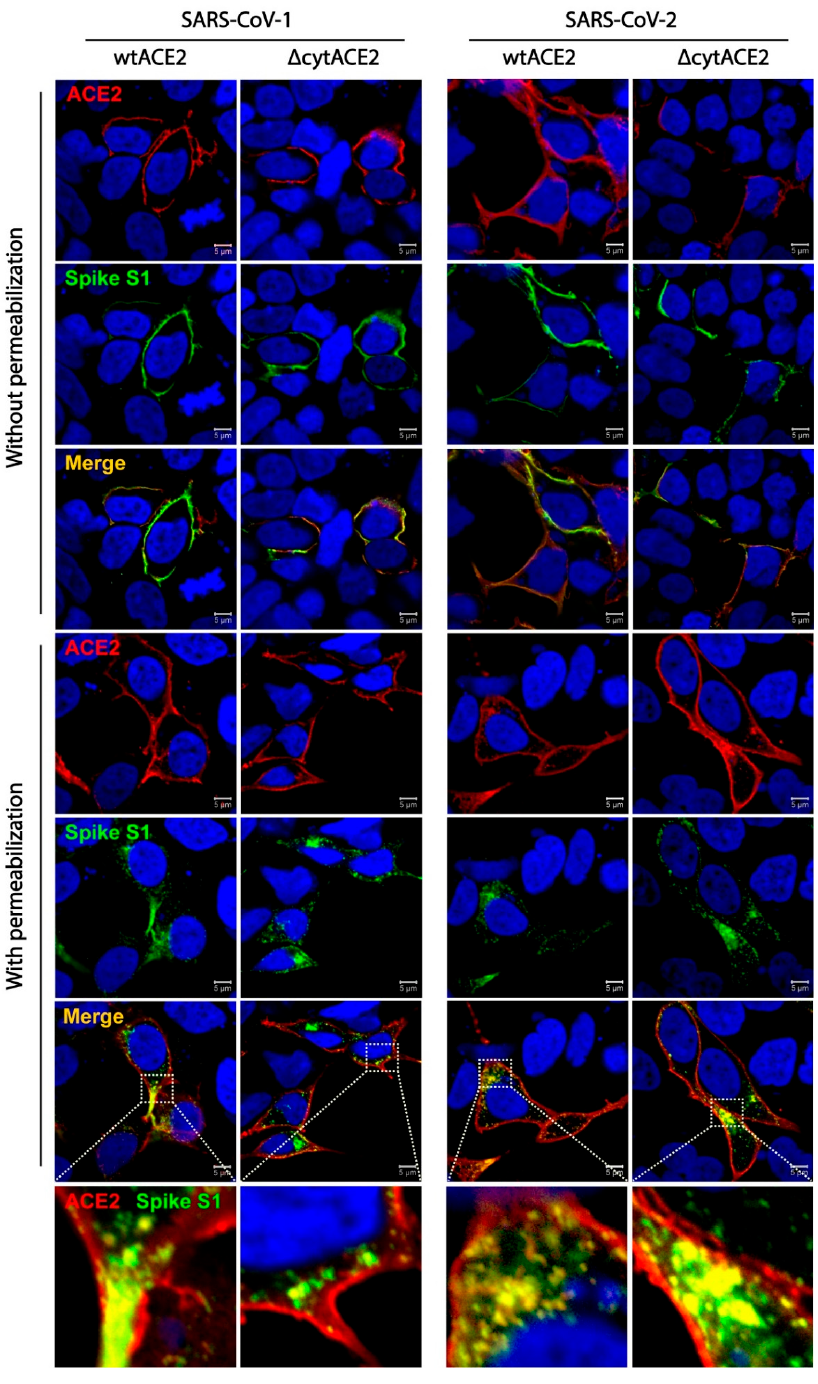
Figure 5. Cellular internalization of ACE2 and ∆ cytACE2 along with SARS-CoV-1 or -2 spike S1-Fc proteins. HEK293T cells were transfected with wtACE2 and ∆ cytACE2 independently and 24 h post transfection, cells were incubated with spike S1-Fc of SARS-CoV-1 and -2 for 4 h at 37 °C. To clearly distinguish between the internalized and surface-localized spike S1-Fc proteins, permeabilized and non-permeabilized cells were tested for internalization and colocalization. S1-Fc was stained using DyLight 488-conjugated anti-human IgG-Fc (green) and ACE2 using goat anti-human ACE2 antibody followed by Alexa Fluor 594-conjugated secondary antibody (red). Nuclei were stained with DAPI (blue). Colocalization of ACE2/ ∆ cytACE2 and spike proteins during internalization shown as merged panel in